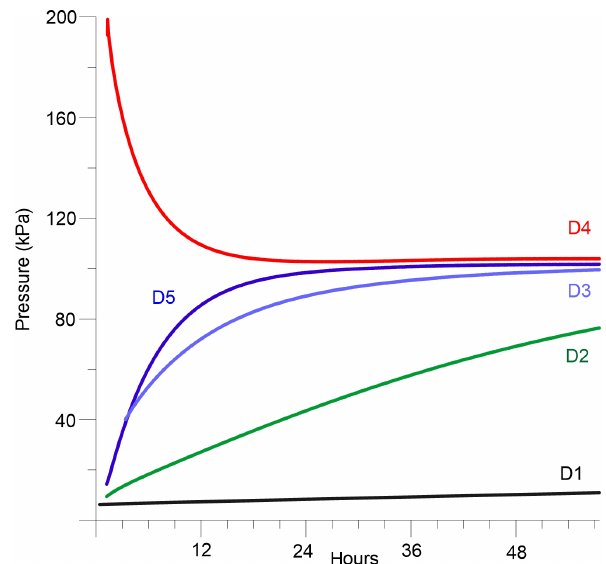
Figure 2. Pressure over time in the boreholes D1 to D5 of the test pillar.